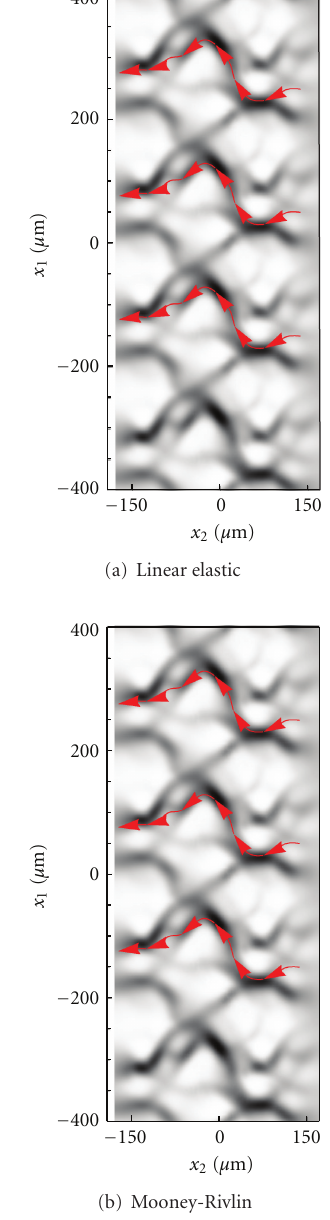
Figure 8: Normalized area of real contact for di ff erent bulk rheo- logies. Dashed contours represent the bearing area paths.